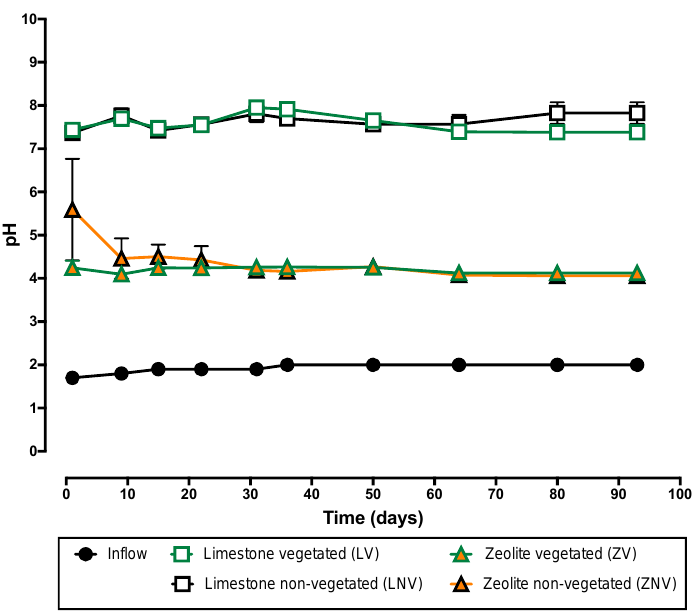
Figure 2. pH profile in the inflow and outflow of the wetland system. Data corresponds to average values, and error bars indicate minimum and maximum values.